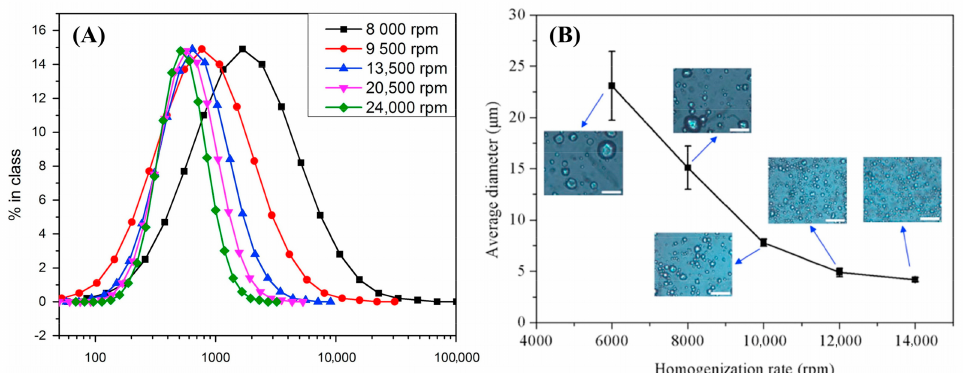
Figure 5. Variation of rotation speed on emulsions. ( A ) 20% octacosane and 5% surfactant mixture of Tween80 and Span20 at 1:1 mass ratio (Reproduced with permission from Ref. [72], Copyright 2016 Elsevier); ( B ) 20% paraffin and 4% surfactant mixture of PVA and PEG-600 at 1:1 mass ratio (Reproduced with permission from Ref. [73]. Copyright 2018 Elsevier) (All % valves in weight